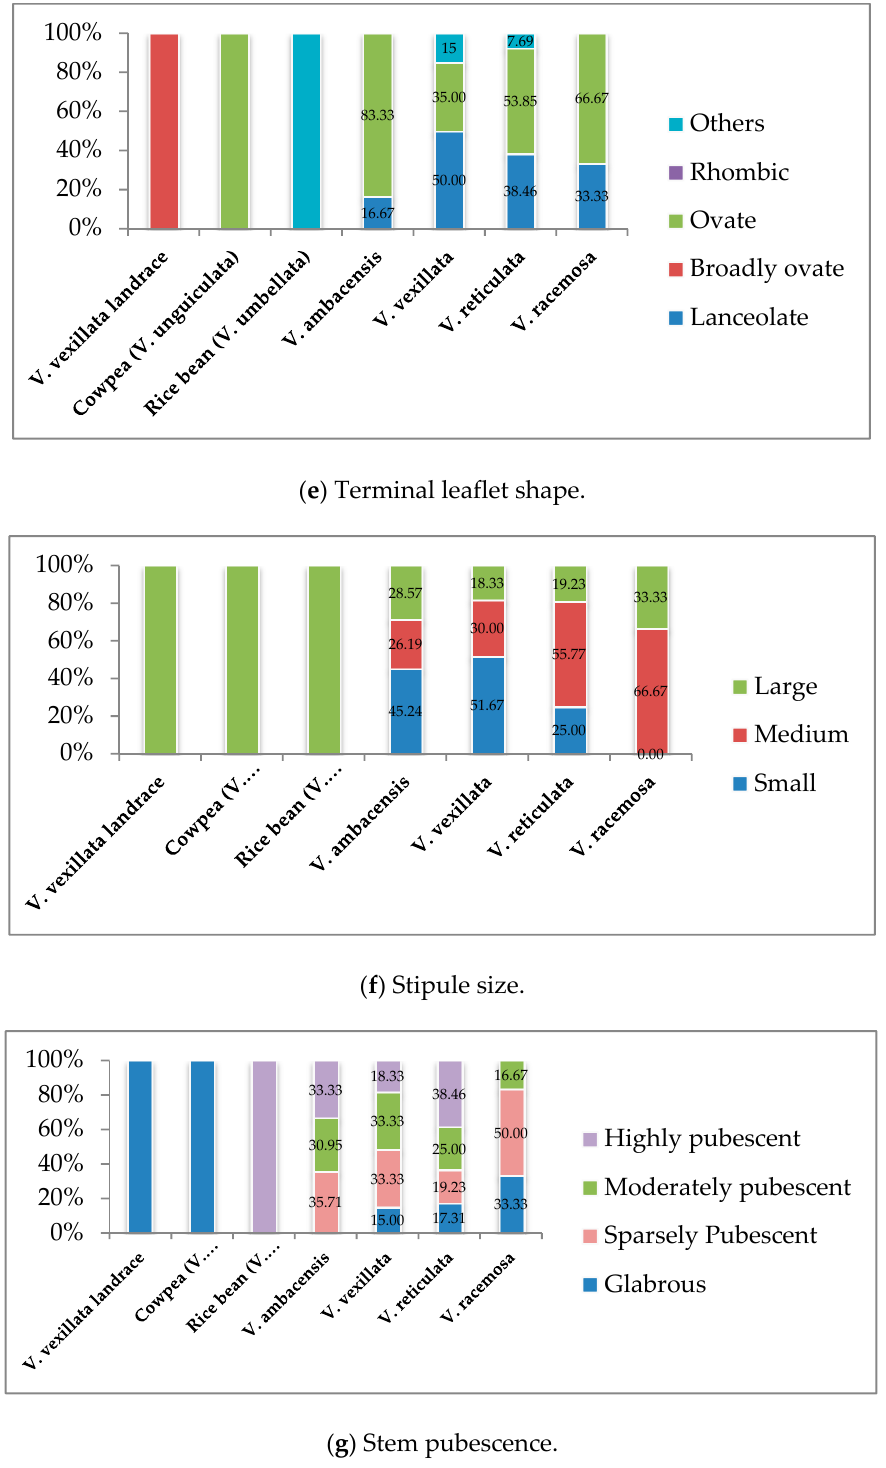
Figure 4. Variations in some selected qualitative traits, evaluated at the vegetative stage. ( a ) leafiness (at 50% flowering); ( b ) leaf pubescence; ( c ) petiole pubescence; ( d ) lobing of the terminal leaflet (at first pod maturity); ( e ) terminal leaflet shape, ( f ) stipule size; ( g ) stem pubescence. Most V. ambacensis (76%) and V. vexillata (63%) accessions presented a sparse leafy character, which was not the case with any of the checks (Figure 4a). Most V. racemosa and V. reticulata accession shared a common feature of intermediate leafiness with cowpea. Rice bean and the